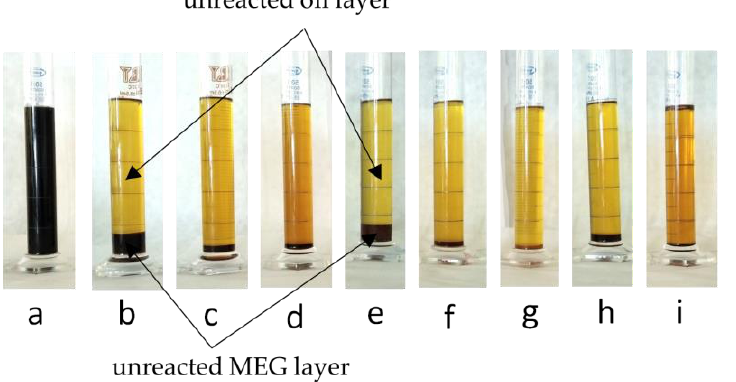
Figure 1. Bio-polyols obtained using the following catalysts: ( a ) H 2 SO 4 , ( b ) H 3 PW 12 O 40 , ( c ) NaOH, ( d ) KOH, ( e ) Al(OH) 3 , ( f ) CH 3 COOK, ( g ) (CH 3 COO) 2 Zn, ( h ) K 2 CO 3 and ( i ) CaO.